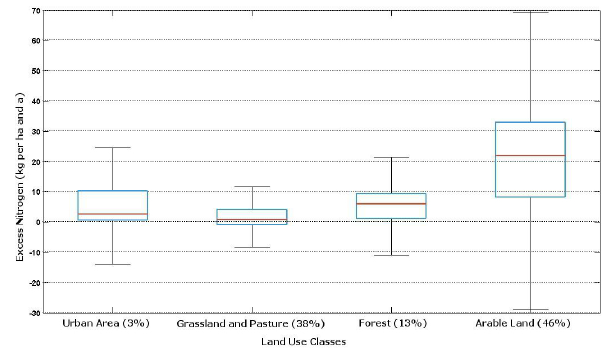
Fig. 5. Box plots of the excess nitrogen per HRU and different land use classes. The percentages highlight the HRU proportion of each land use class. The upper border of the box (blue) depicts the upper or third quartile (Q.75) of the distribution, while the lower bound- ary describes the lower or first quartile (Q.25). The length of the Whiskers (black) represent 1.5 times of the interquartile distance and describes the dispersion of the distribution. The central ten- dency of the distribution is expressed by the median (red). Outliers are not